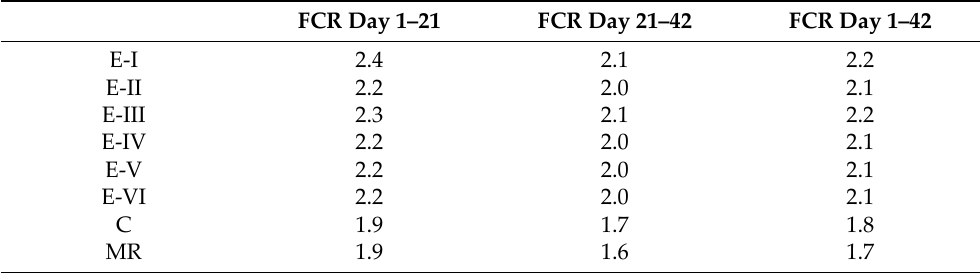
Table 5. The effects of 0.2% of MR on FCR of broiler chicks fed diets containing aflatoxin (0.1 mg/kg) or T‑2 toxin (0.5 mg/kg), singly or in combination, during the study.